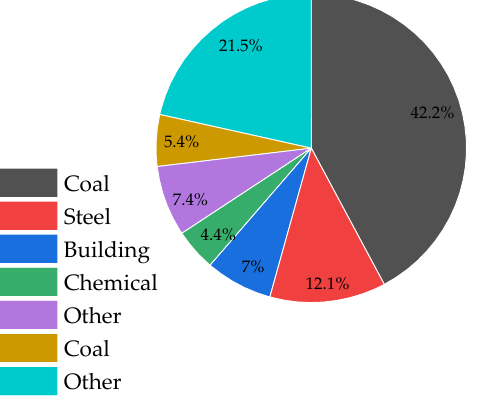
Figure 1. Coal Industry Chain. The utilization pathways of coal point to the steel, coal chemical, power generation, and building materials industries, respectively. Their carbon emissions account for the carbon emissions of energy activities in China as shown in Figure 2.